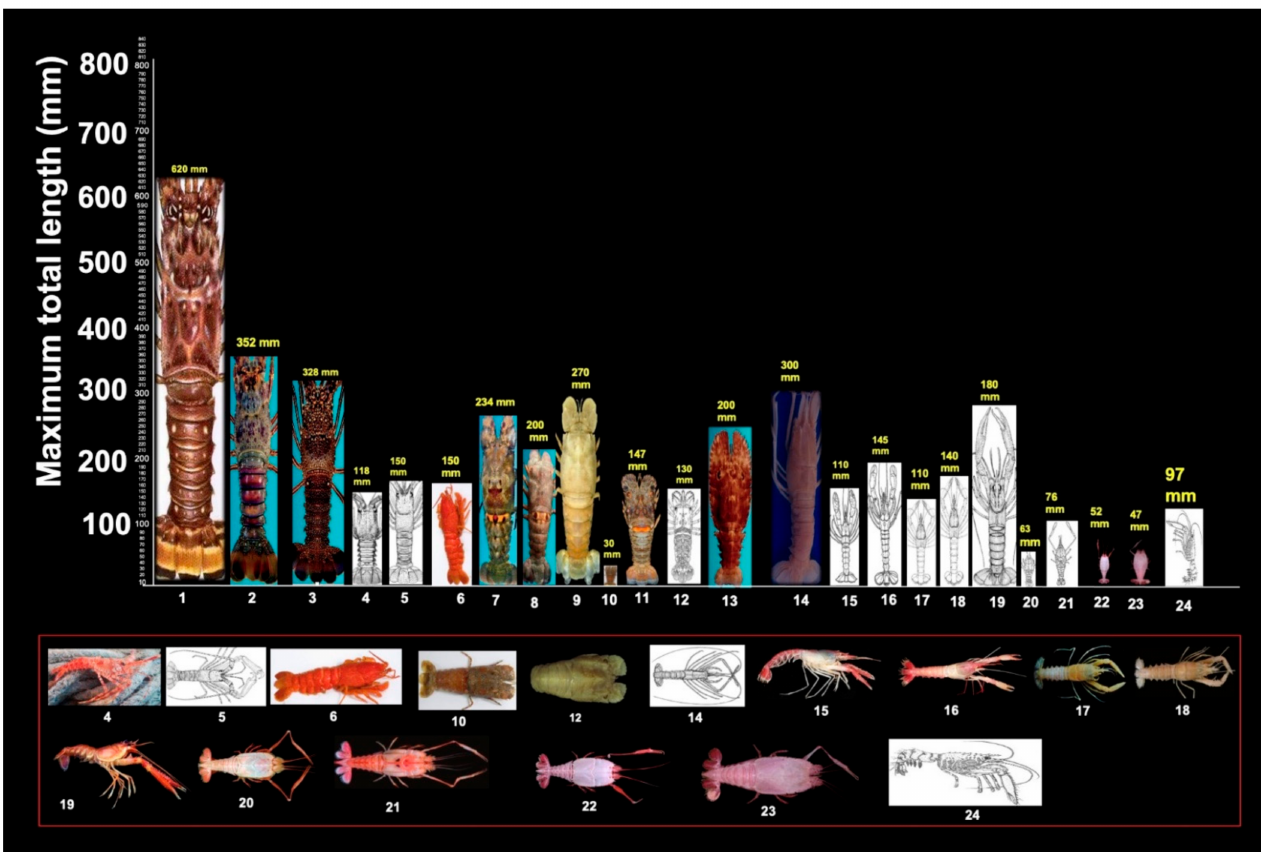
Figure 5. Maximum total length (MTL) of 24 lobster species occurring on continental shelf of Brazil (Table 1). Lower frame features enlarged pictures of small lobster species. Species (Appendix A) were distributed in following families: Palinuridae : 1. Brazilian form of Panulirus argus ; 2. Panulirus laevicauda ; 3. Panulirus echinatus ; 4. Palinustus truncatus ; 5. Justitia longimanus , 6. Palinurellus gundlachi . Scyllaridae : 7. Scyllarides delfosi ; 8. Scyllarides brasiliensis ; 9. Scyllarides deceptor ; 10. Scyllarus chacei ; 11. Scyllarus depressus ; 12. Scyllarus americanus ; 13. Parribacus antarcticus . Nephropidae : 14. Acanthacaris caeca ; 15. Nephropsis aculeata ; 16. Nephropsis rosea ; 17. Nephropsis agassizii ; 18. Nephropsis neglecta ; 19. Metanephrops rubellus . Polychelidae : 20. Stereomastis sculpta ; 21. Polycheles typhlops , 1862; 22. Pentacheles laevis ; 23. Pentacheles validus . 24. Enoplometopus antillensis . Table 1. Morphometric measurements of 24 lobster species reported from continental shelf of Brazil: maximum total length